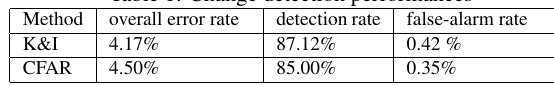
Figure 4: Final results of the unsupervised change detection for experimental data. Details of change obtained in case of (a) the generalized K&I method proposed in this paper (b) CFAR method. Color legend: white, change; gray, no-change; black, unlabeled pixels Table 1: Change detection